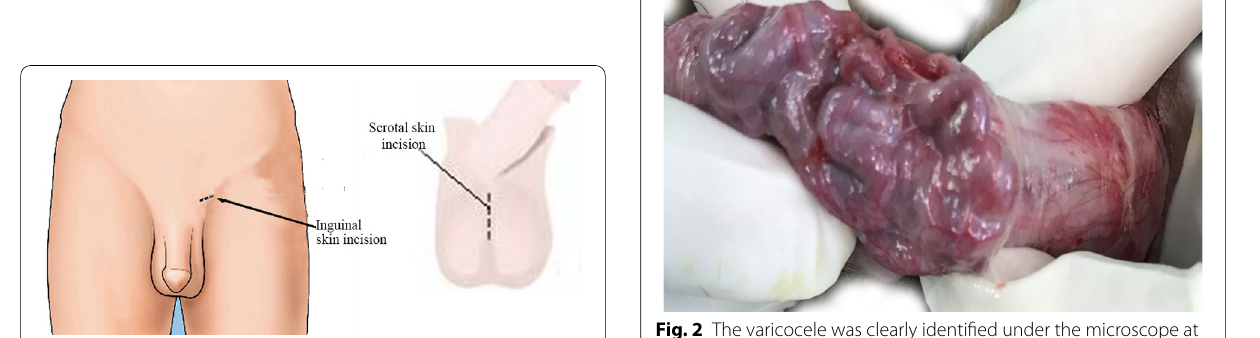
Fig. 1 Scrotal and inguinal skin incision